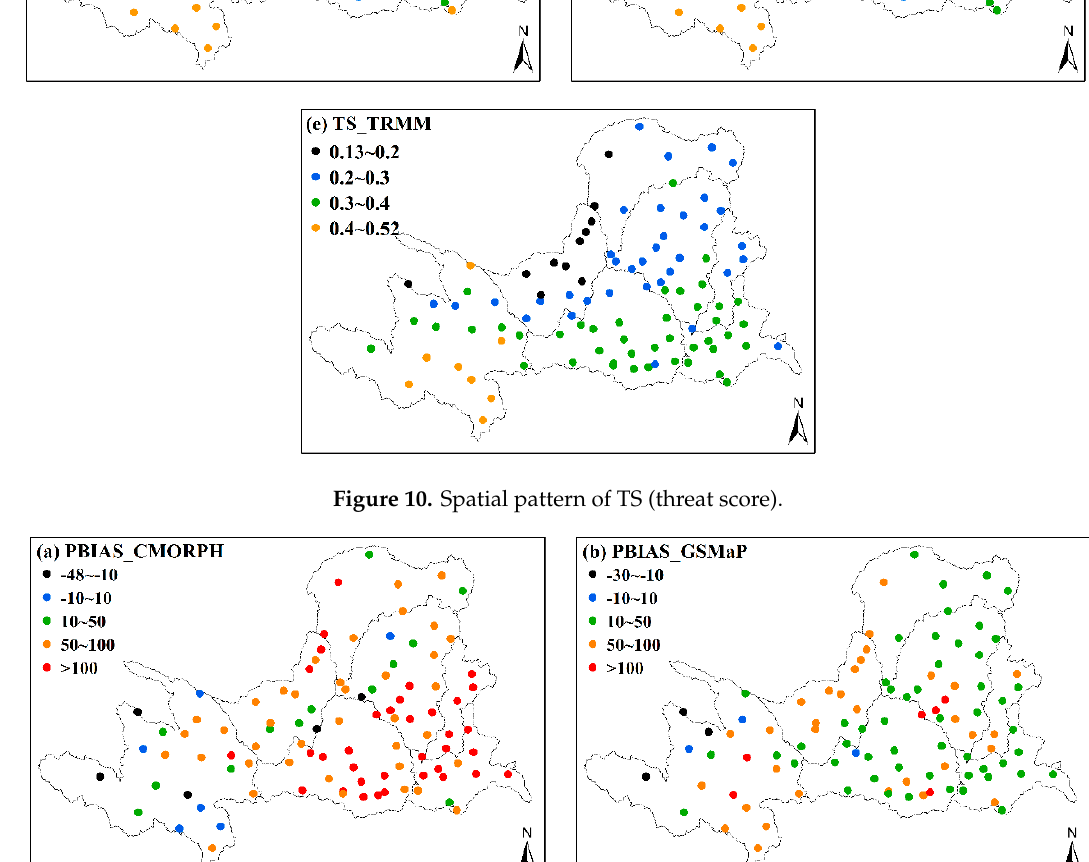
Figure 10. Spatial pattern of TS (threat score).